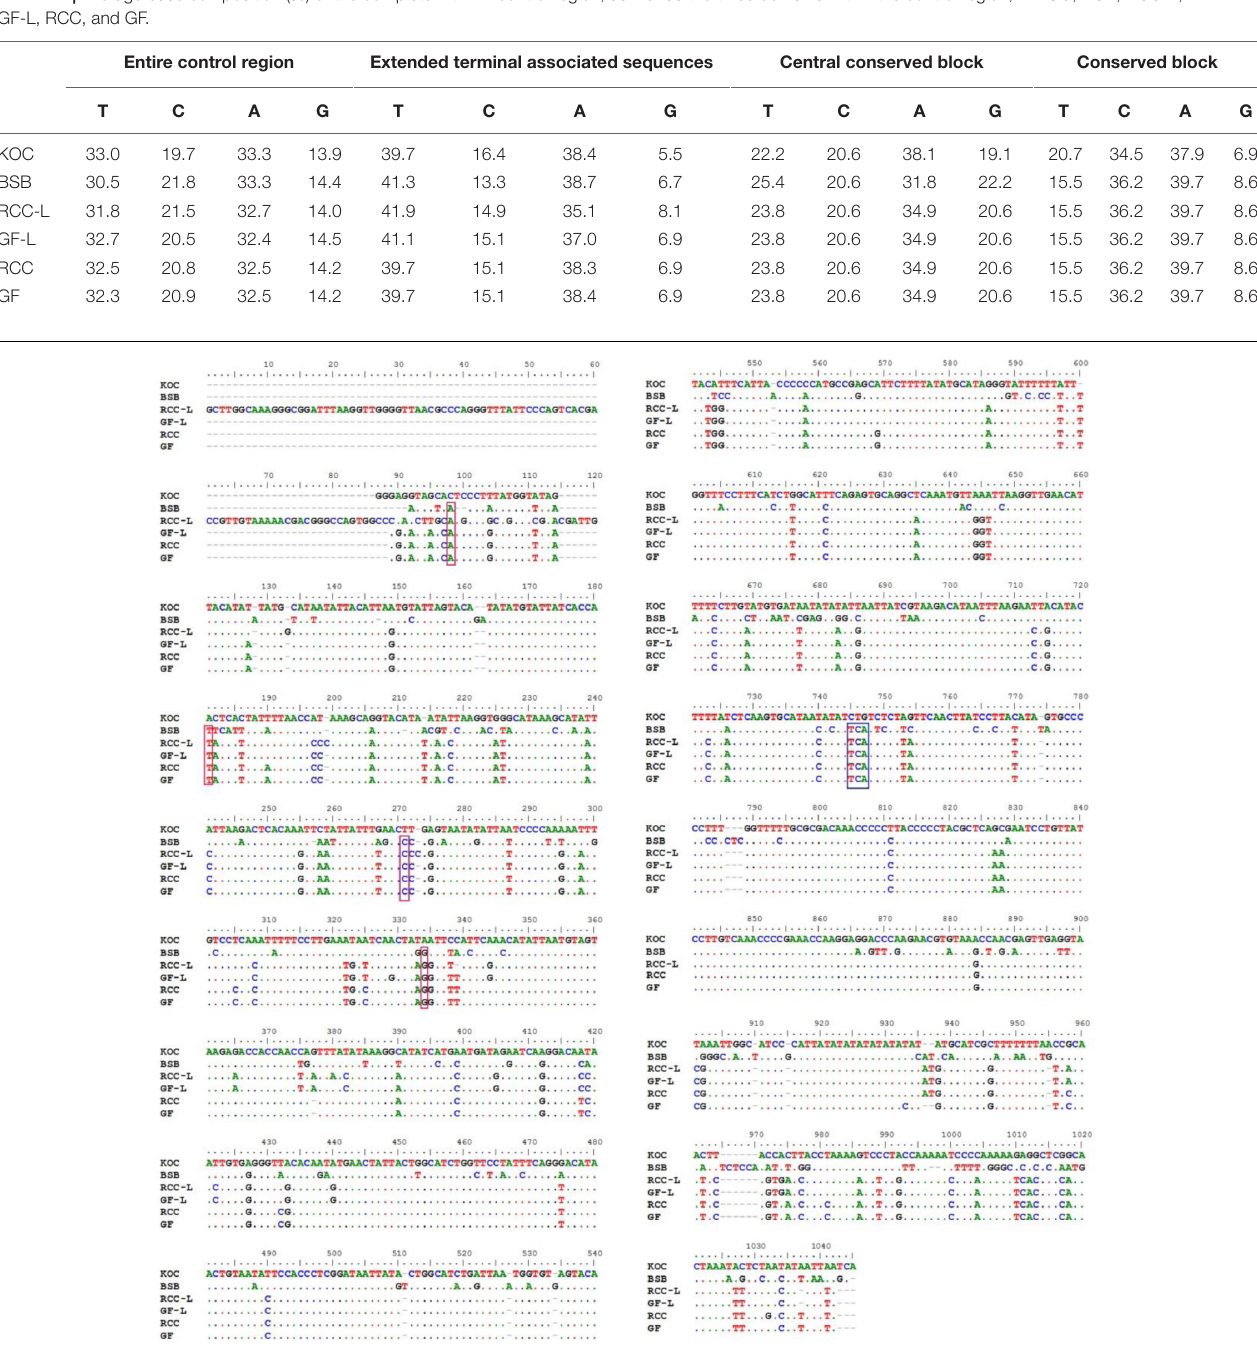
FIGURE 3 | The alignment of the control regions of KOC, BSB, RCC-L, GF-L, RCC, and GF. Dots represent conserved bases, red boxes indicate single-base insertions, and the blue rectangular box indicates the insertion of genetic material from BSB.